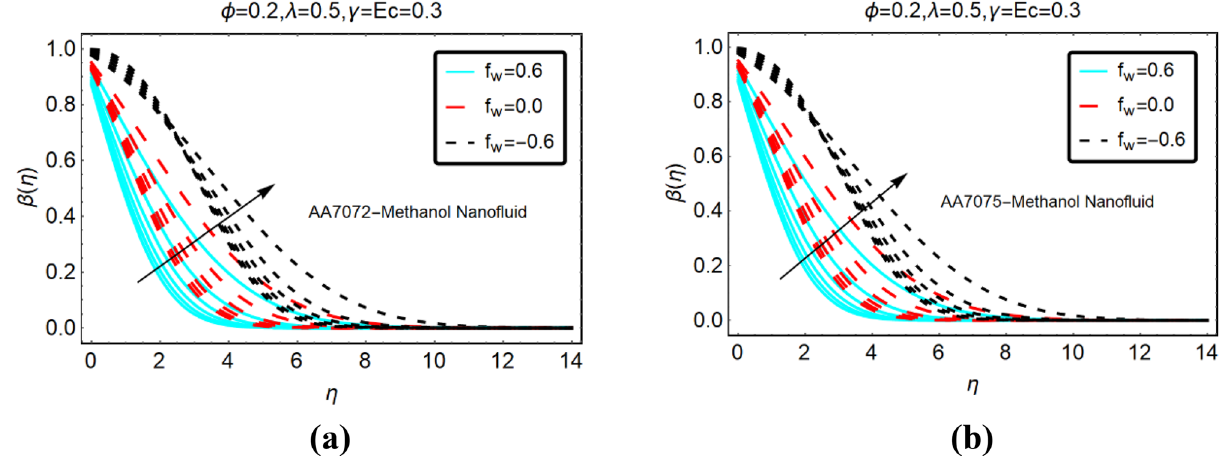
Figure 4. The effects of Rd on β(η) ( a ) AA7072-Methanol ( b ) AA7075-Methanol for heat generation.